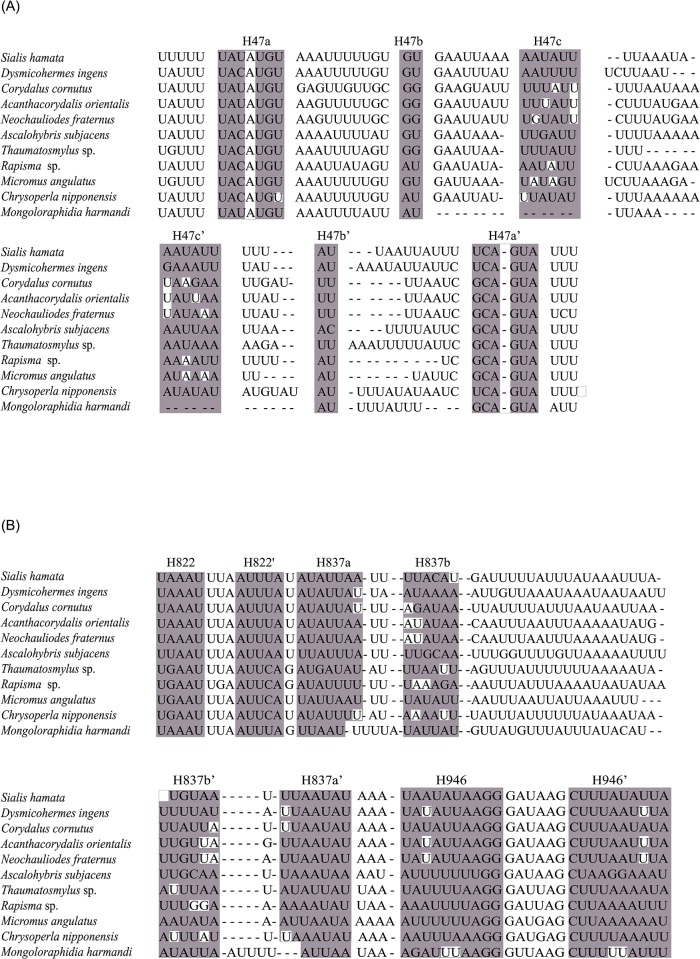
Alignments of helices for eleven representative neuropterid species.(A) Alignments of the helix 47 in rrnS. (B) Alignments of the helix 837 in rrnL. Helices are highlighted by grey box and numbered as diagrams of the full secondary structures. No color areas in each helix indicate the unpaired regions.